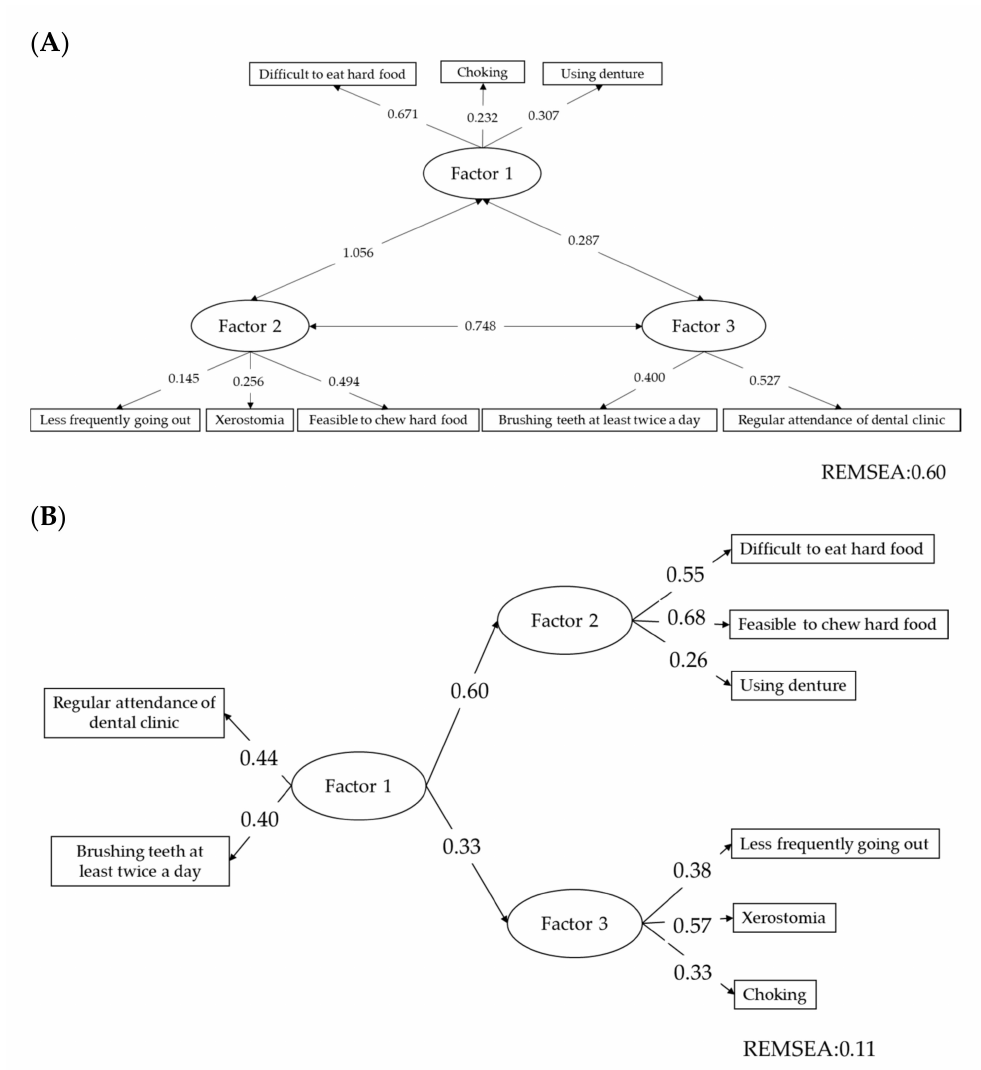
Figure 1. Path diagram of the items of the oral frailty screening questionnaire. ( A ) Default model. ( B ) Improved model. In the default model, the path between Factor 2 and 3 was not statistically significant. It was removed in the improved model. Fitness index REMSEA was improved when compared with the default model. All the paths were statistically significant. REMSEA: Root Mean Square Error of